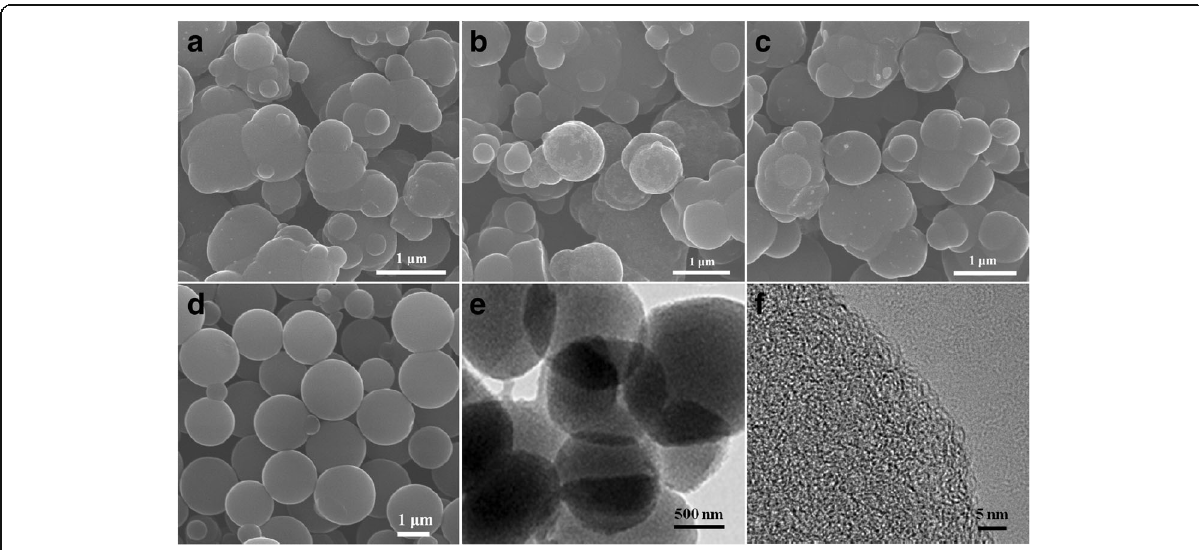
Fig. 1 SEM images of the NMCSs samples synthesized at different ethanol/water volume ratios of ( a ) 7:1, ( b ) 4.3:1, ( c ) 3:1 and ( d ) 1:1, ( e ) TEM and ( f ) HR-TEM images of the